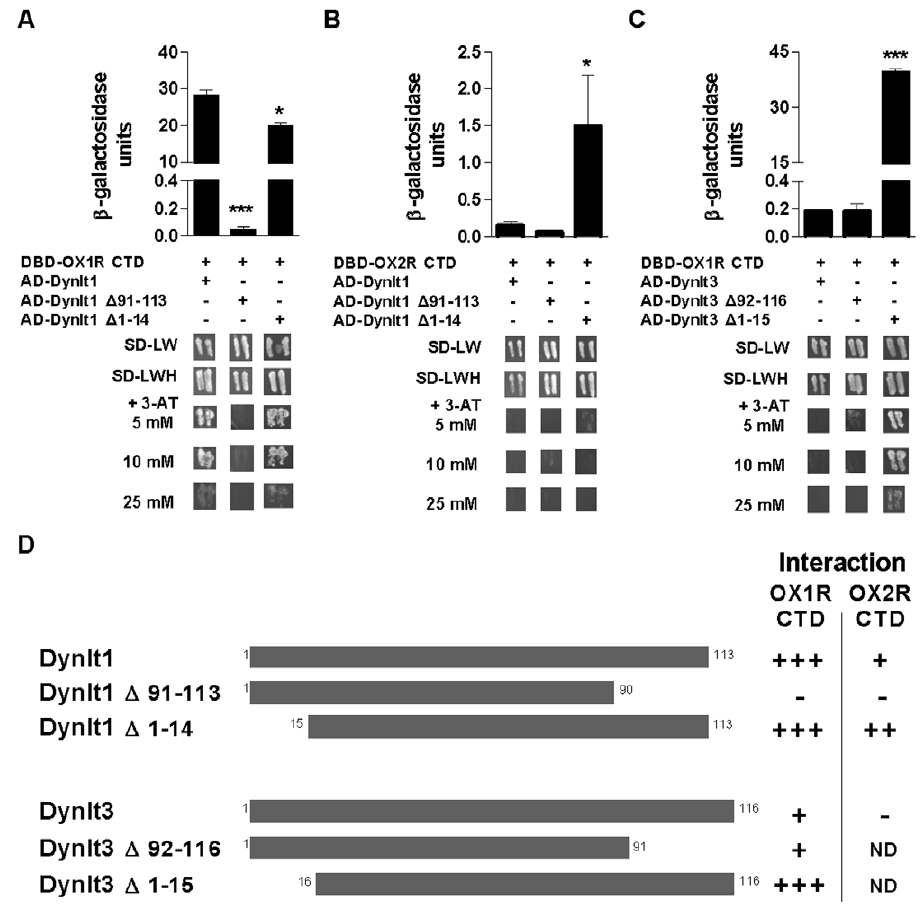
Figure 3. Domains of Dynlt1 and Dynlt3 involved in their interaction with orexin receptors. ( A, B ) b -galactosidase assays (top panels) and HIS3 assays (bottom panels) were performed on yeast transformed with plasmids expressing different combinations of orexin receptor and Dynlt1/ Dynlt3. The carboxy-terminal domain of Dynlt1 is required for interaction with OX1R and OX2R CTDs, while the N-terminal b sheet of Dynlt1 is dispensable for the interaction with OX1R CTD and even hinders the interaction with OX2R CTD. ( C ) The interaction of Dynlt3 with OX1R CTD remains unaltered in absence of the carboxy-terminal domain of Dynlt3, while deletion of its N-terminal b sheet favors the interaction with OX1R CTD. ( D ) Summary of Dynlt1 and Dynlt3 constructs tested and their relative interaction strength with OX1R CTD and OX2R CTD. Dynlt1 D 91–113, Dynlt1 lacking a.a. 91–113; Dynlt1 D 1–14, Dynlt1 lacking a.a. 1–14; Dynlt3 D 92–116, Dynlt3 lacking a.a. 92–116; Dynlt3 D 1–15, Dynlt3 lacking a.a. 1–15. ND, not determined. Experiments were performed 3 times, with similar results, and the average is presented. *: p , 0.05 and ***: p , 0.001 vs transformation with wild-type Dynlt1 or Dynlt3.